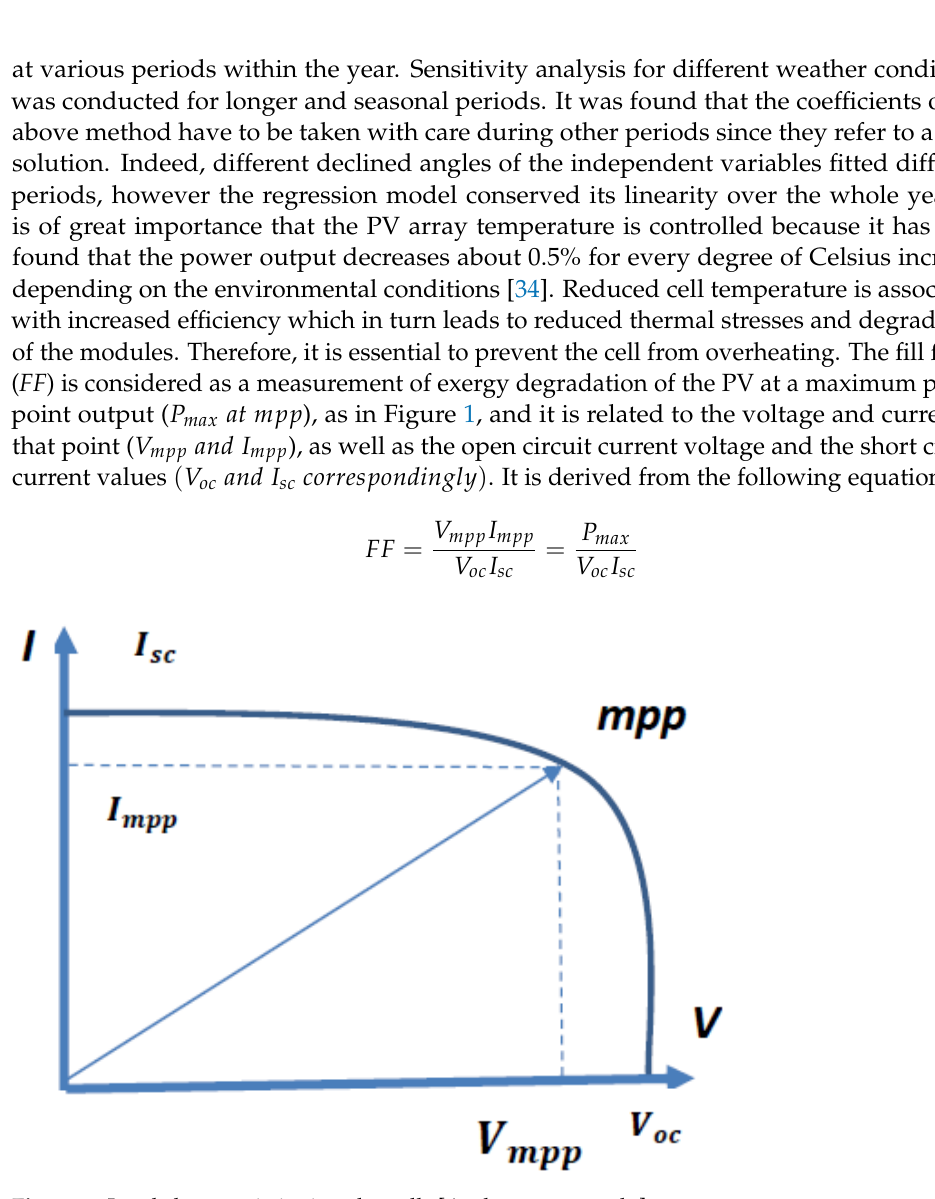
Figure 1. Load characteristics in solar cells [Authors own study].